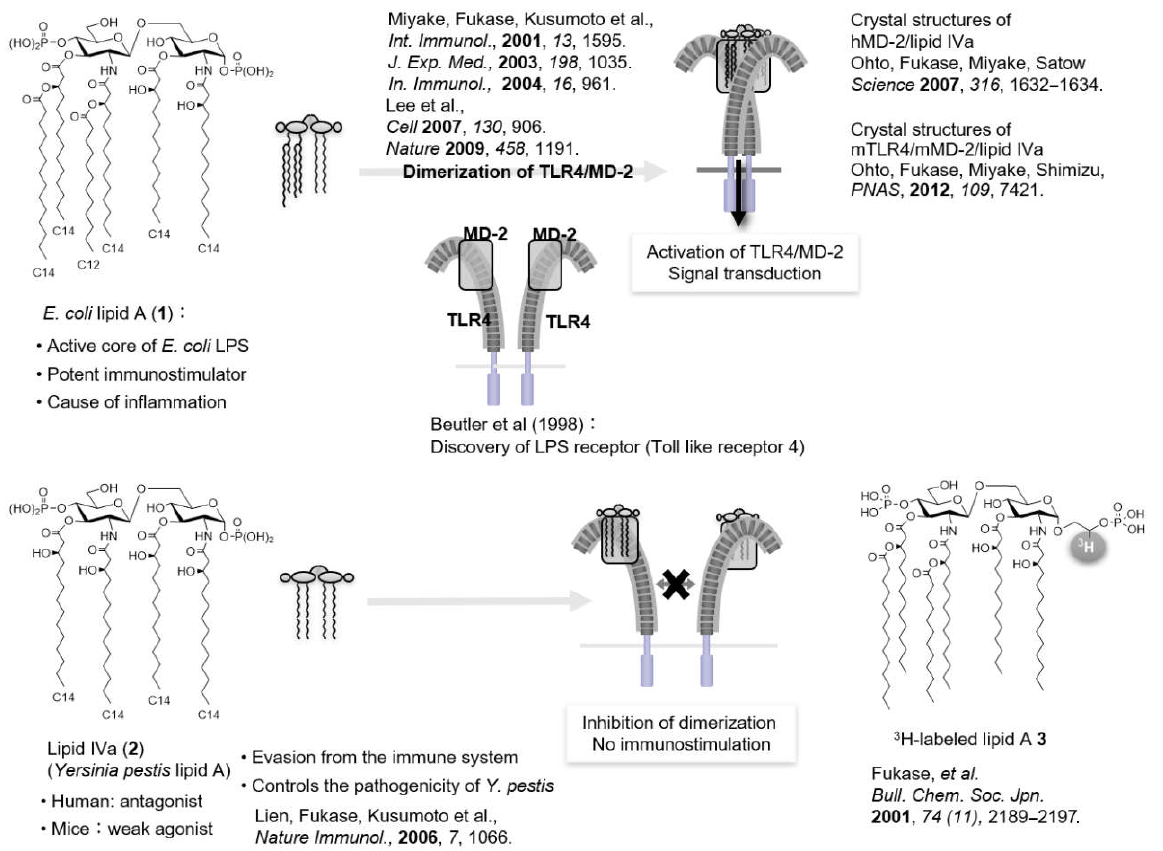
Figure 5. Molecular mechanism of TLR4/MD2 dimerization process.